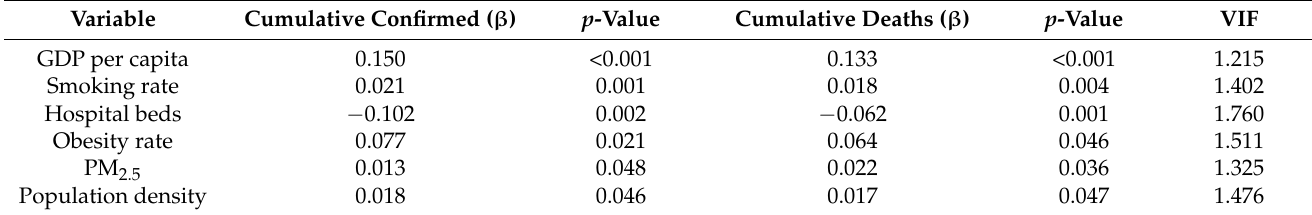
Table 3. Multivariate Linear Regression based on MESF results of